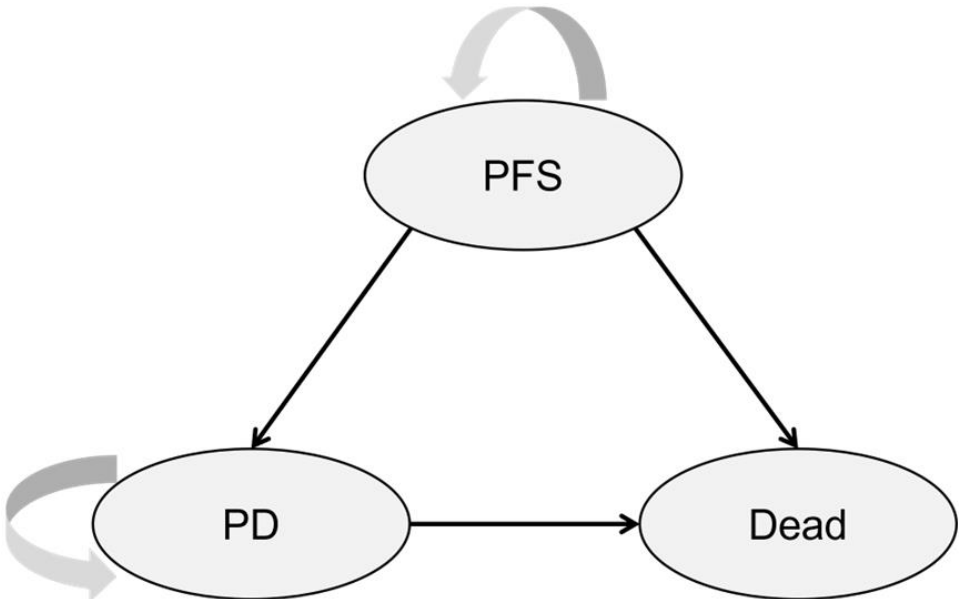
Figure 1. Partitioned survival model for HER2-positive metastatic breast cancer patients. Abbreviations: PFS, progression-free survival; PD, progressive disease; HER2, human epidermal growth factor receptor 2.